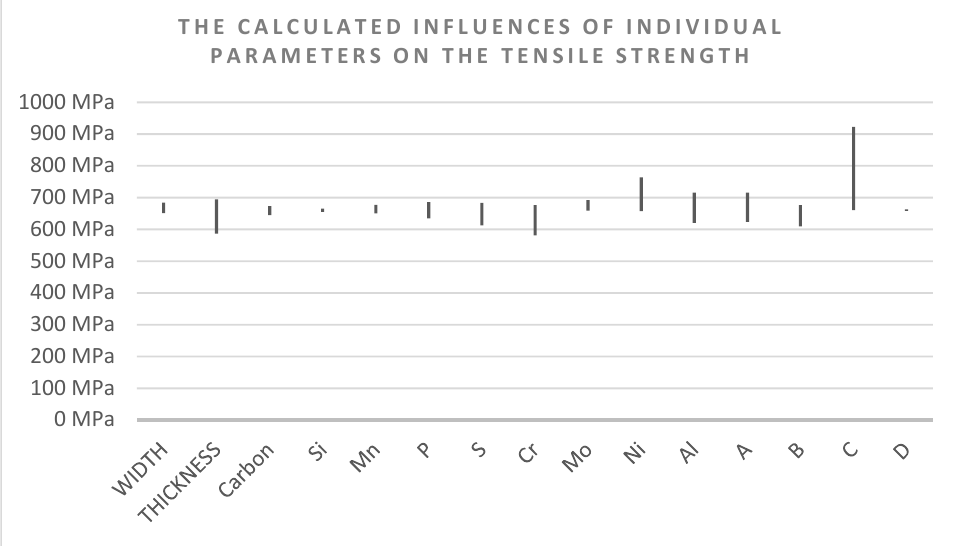
Figure 2. The calculated influences of individual parameters on the tensile strength while separately changing individual parameter within the individual parameter range. The next model significantly predicts the yield strength ( p < 0.05, ANOVA) but only 7.15% of total variances can be explained by independent variables variances (R-square). Significantly influential parameters ( p > 0.05) are hot rolled bar width (WIDTH) and thickness (THICKNESS) and chromium content (Cr).